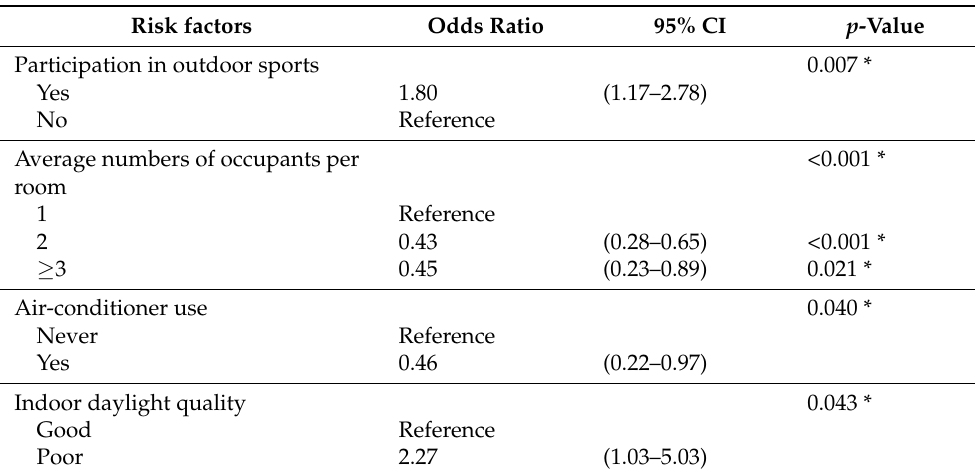
Table 3. Multivariate analysis of risk factors for dengue virus